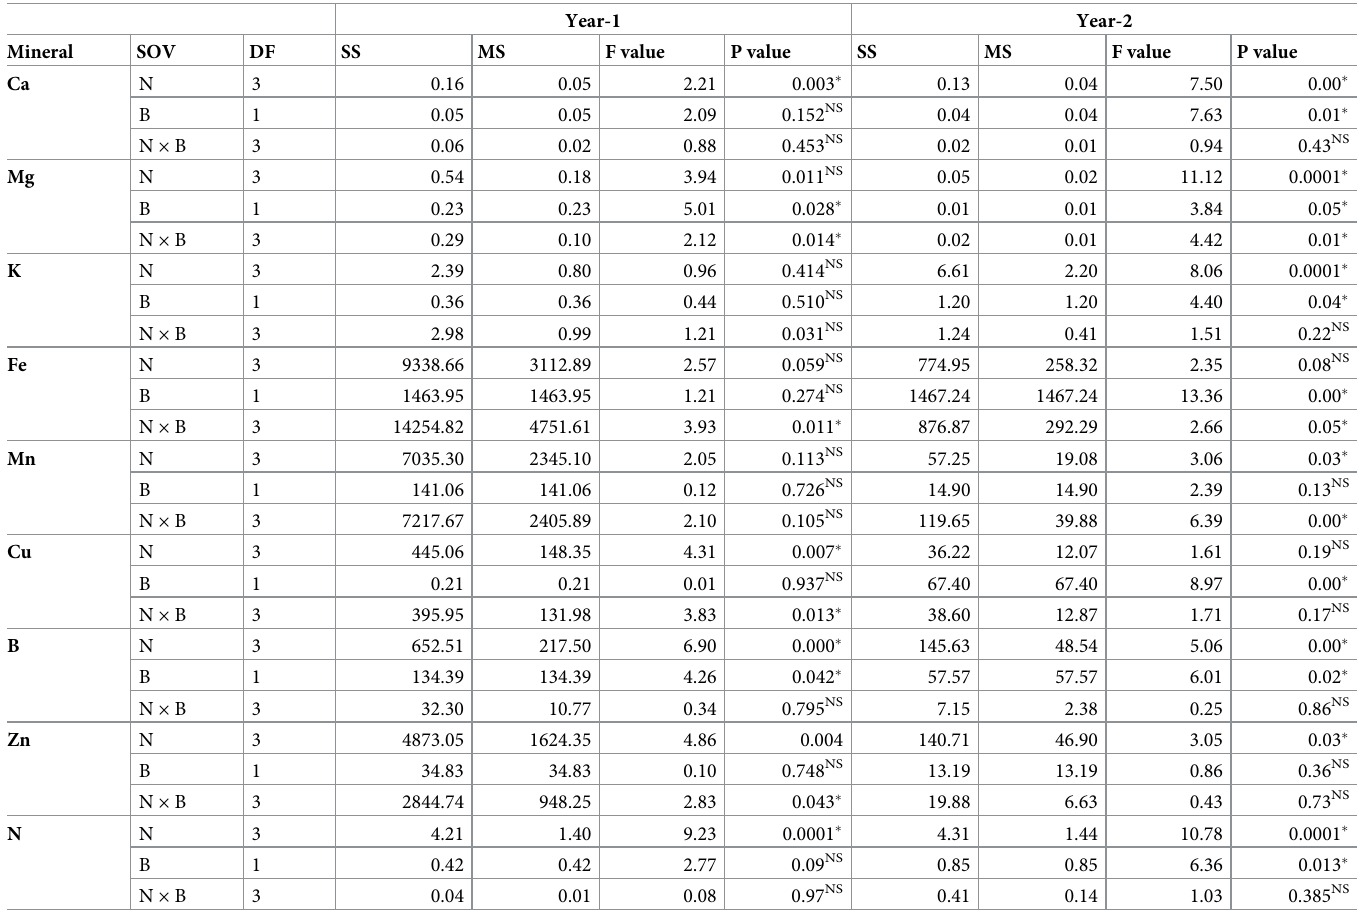
Table 1. Analysis of variance of different mineral uptake traits of grafted watermelon rind grown under various nitrogen and boron